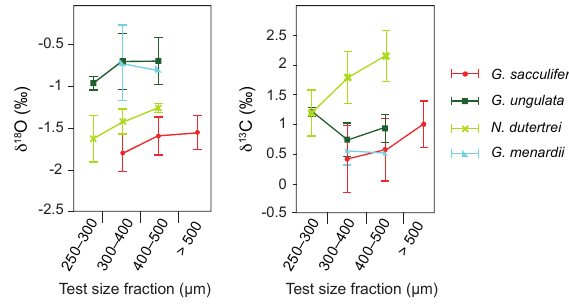
Figure 5. Stable oxygen and carbon isotopes (average δ 18 O calcite and δ 13 C calcite ± standard deviations) compared to different test size fractions of living planktic foraminifers (only species with more than one analysed test size fraction are